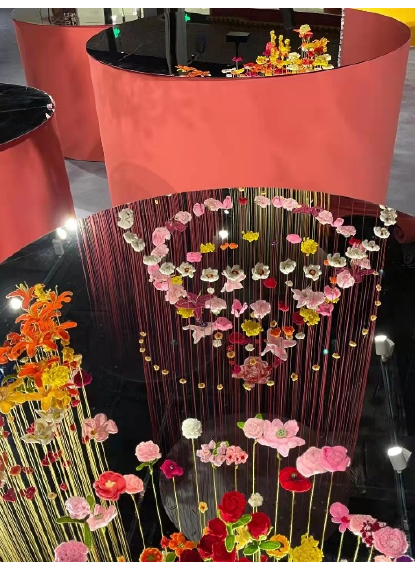
Figure 1. Public artwork “Flowers of Velvet, Mirror Image of Spring” [38].